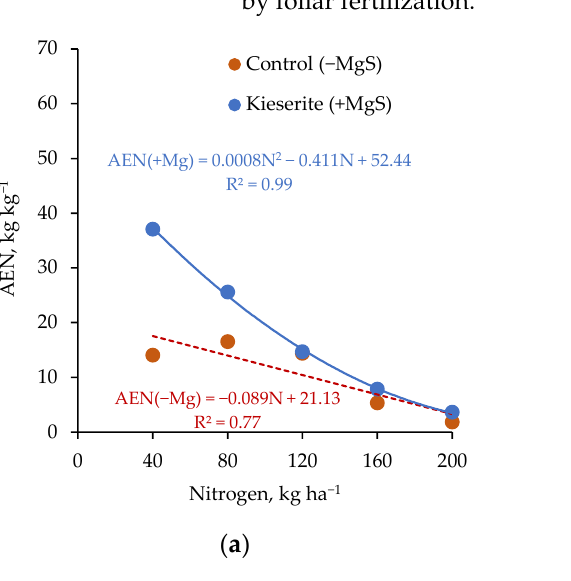
Figure 13. Effect of nitrogen application (40, 80, 120, 160 and 200 kg N ha − 1 ) on the agronomic efficiency of nitrogen (AEN), calculated for white sugar yield of sugar beet, depending on the availability of magnesium in the soil — kieserite application at a rate of 24 kg Mg ha − 1 . Mean for two years for sandy soil ( a ) and loamy soil ( b ). Source: Pogłodziński et al. [ 182].